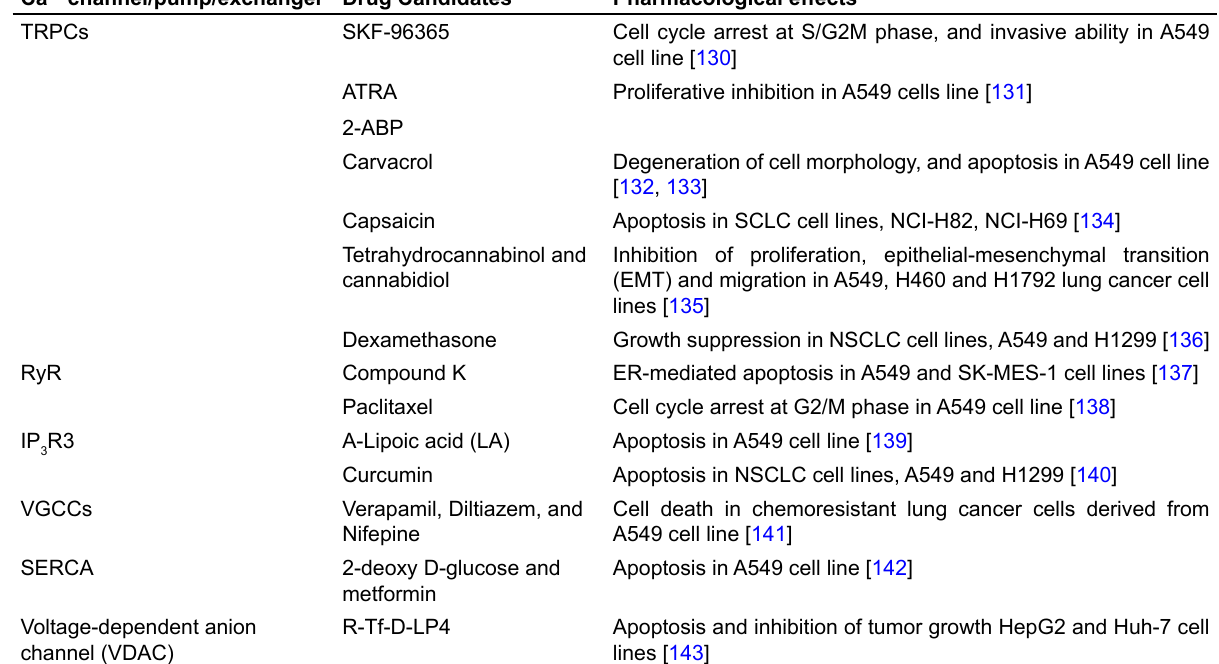
Table 2. Summary of the major compounds targeting Ca 2+ channels/pumps/exchangers in lung cancer progression Ca 2+ channel/pump/exchanger Drug